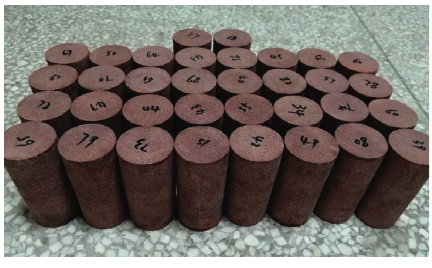
Figure 3: Sandstone